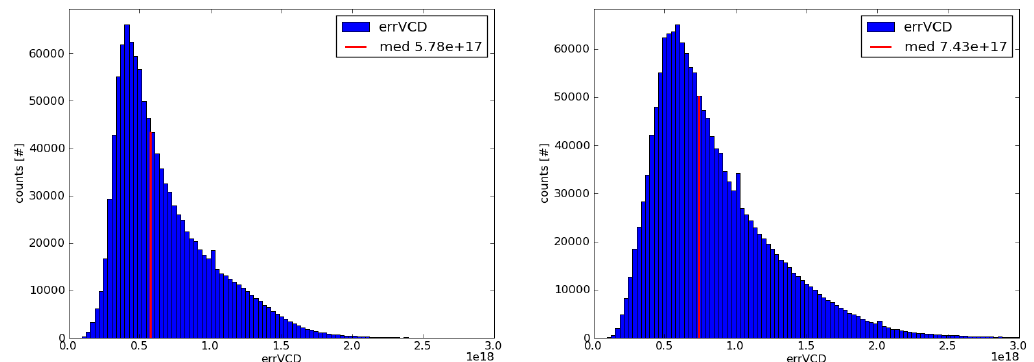
Fig. 16. Histograms of carbon monoxide vertical column density errors, three-year (2003–2005) seasonal averages. Left: winter; right: summer.